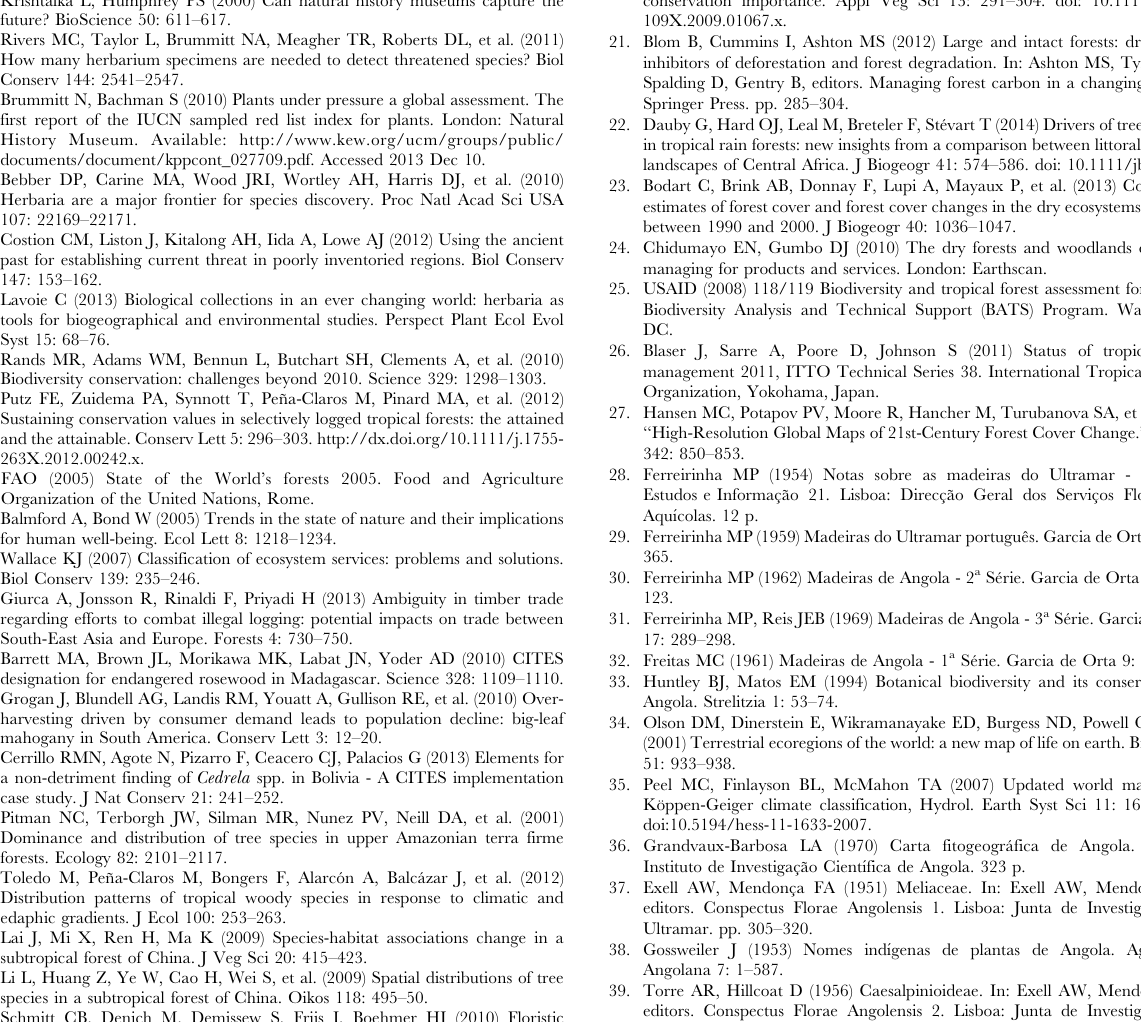
Table S4 Characteristics of the 18 timber species studied, including information about their family, synonymy, common names, habit and ecology, and timber characteristics and